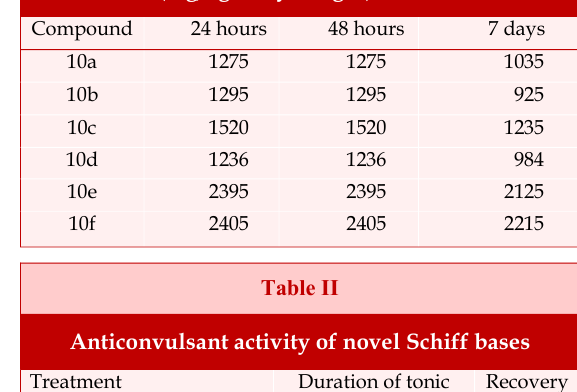
LD 50 (mg/kg body weight) of Schiff